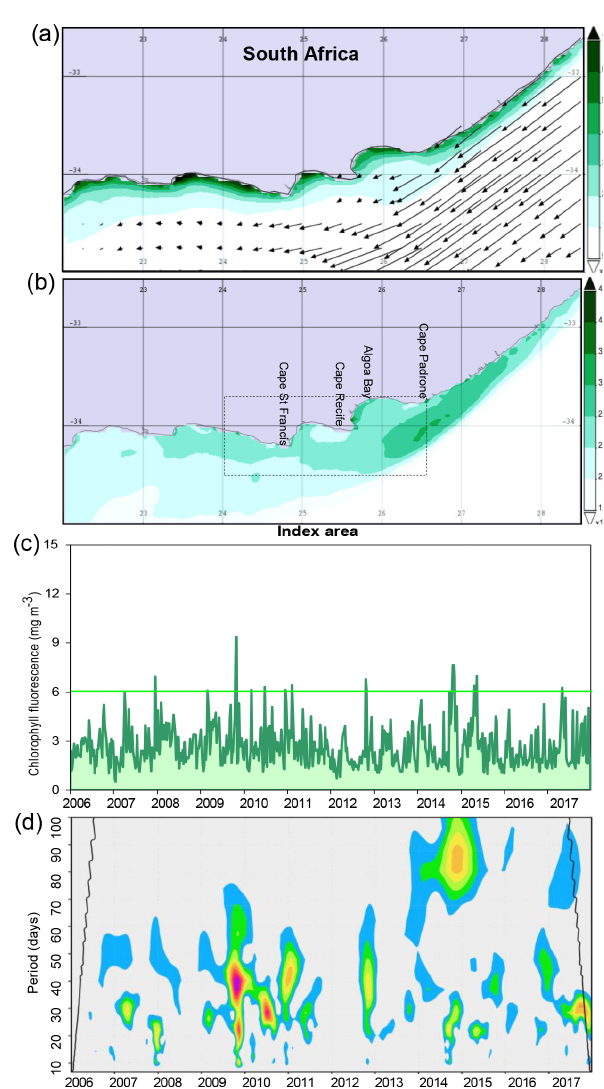
Figure 2. MODIS 2006–2017 mean (a) chlorophyll concentration (mgm − 3 ) with SODA3 mean near-surface currents and (b) fluo- rescence line height (Wm 2 ) and index area. (c) Time series of 8d index-area chlorophyll fluorescence; composite cases >6mgm − 3 . (d) Wavelet spectra energy of the time series, shaded from 90% to 99%